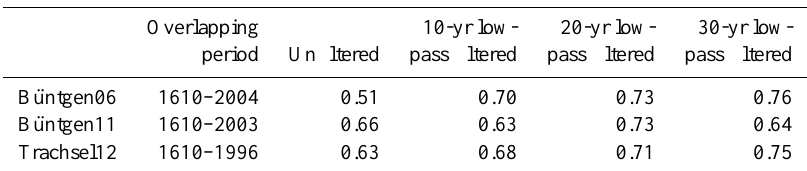
Table 5. Results of Pearson correlation values (p < 0.005) computed over the overlapping period between AdaPres reconstruction and the three compared series (B¨untgen et al., 2006 (B¨untgen06), B¨untgen et al., 2011 (B¨untgen11), Trachsel et al., 2012 (Trachsel12)). Before and after applying a 10-, 20- and 30-yr Gaussian low-pass filter.